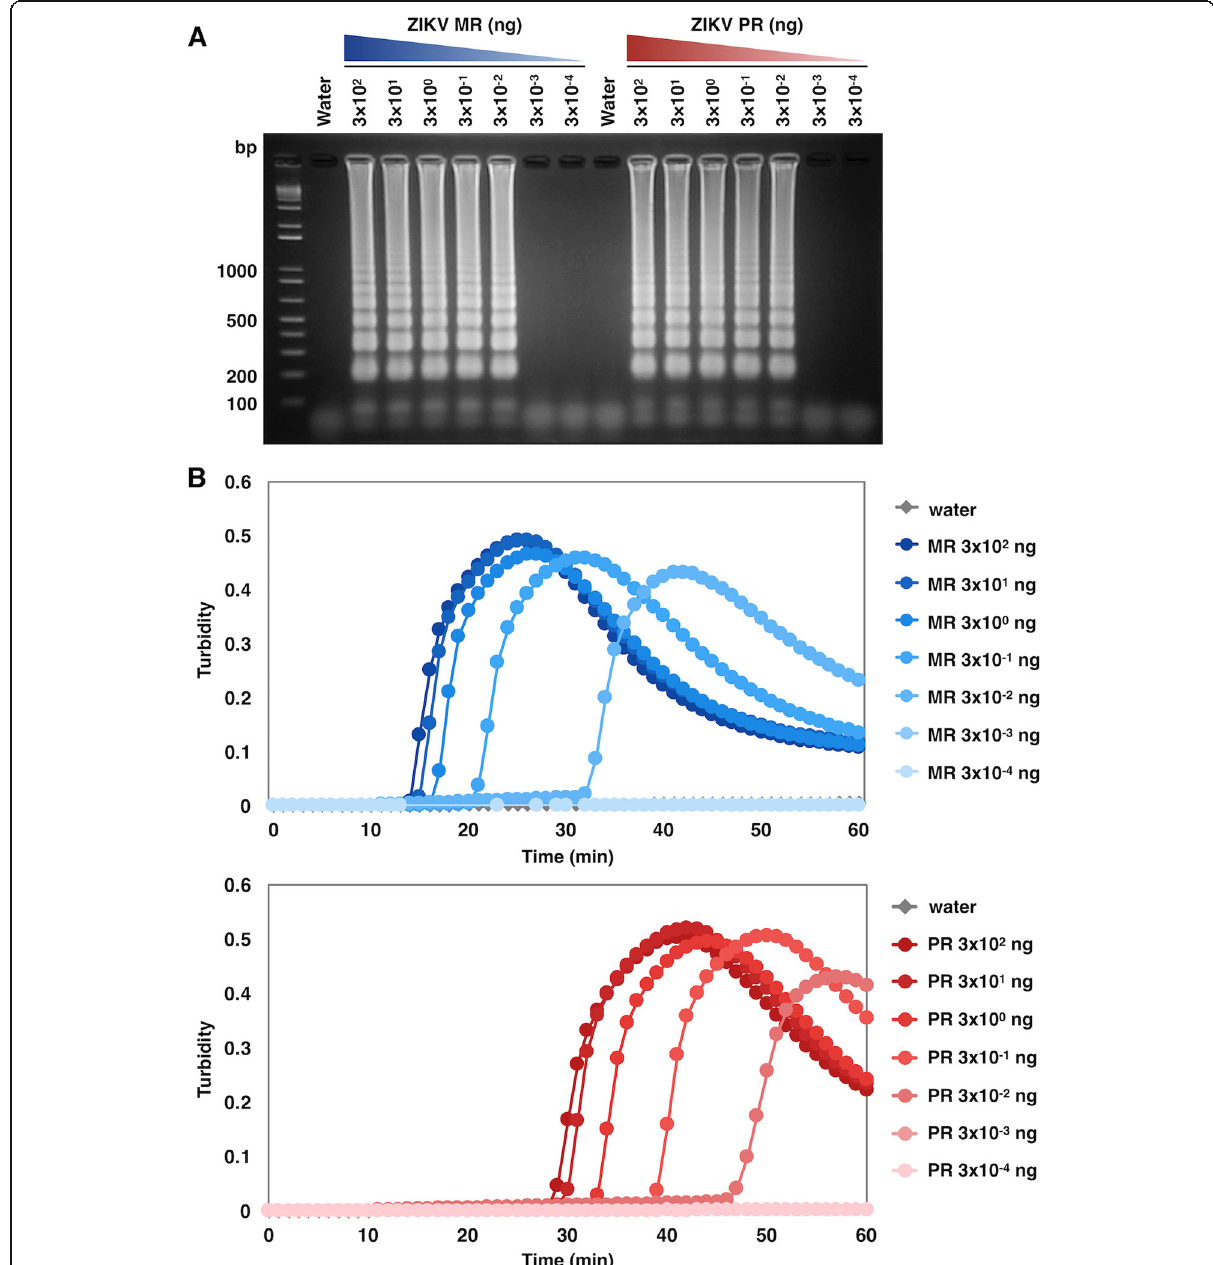
Fig. 2 Sensitivity of RT-LAMP for the detection of ZIKV MR and PR strains. RNA from each ZIKV strain (3 × 10 2 , 3 × 10 1 , 3 × 10 0 , 3 × 10 − 1 , 3 × 10 − 2 , 3 × 10 − 3 , and 3 × 10 − 4 ng) was used as a template for RT-LAMP reactions for 60 min at 62 °C. Water served as a negative control in RT- LAMP reaction. a Agarose gel electrophoresis of the RT-LAMP amplified products. The reaction mixtures were electrophoresed on a 2% agarose gel. Numbers on the left indicate migration of the molecular weight marker (bp). b Amplification of ZIKV NS3 of the MR and PR strains monitored using a real-time turbidimeter (turbidity at 650